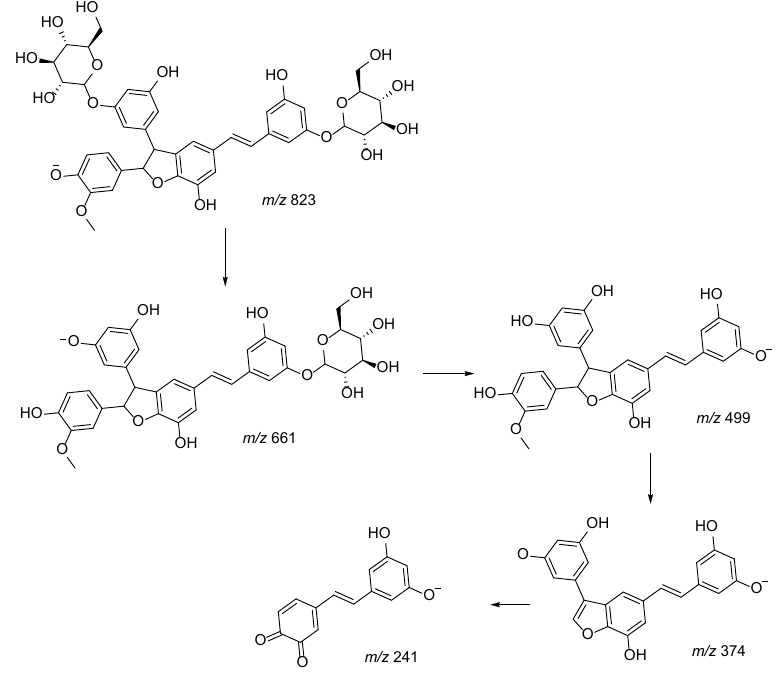
Figure 4. Proposed fragmentation pattern of piceaside with furanic group.